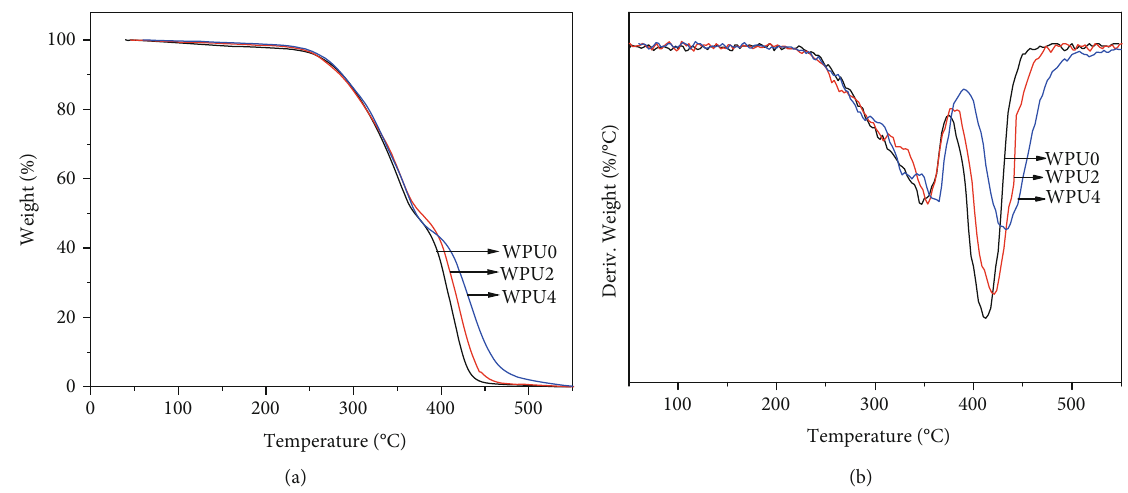
Figure 5: Thermal performance of WPU fi lms: (a) TGA curve of LEPS-modi fi ed WPUs and (b) DTG curve of LEPS-modi fi ed WPUs. Table 4: TG results of WPU fi lms.